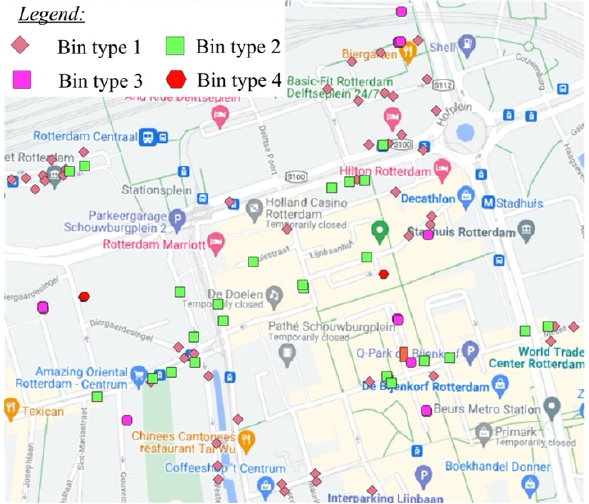
Figure 11. Positions of extracted public garbage bins overlaid on a Google map